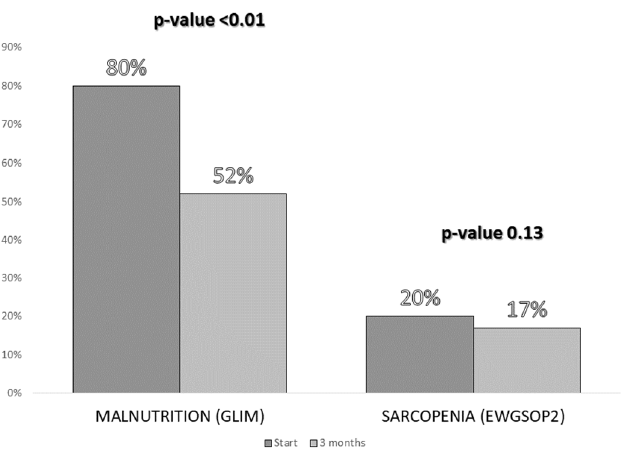
Figure 4. Comparison of the percentages of malnutrition (according to the Global Leadership Initiative on Malnutrition (GLIM) criteria) and sarcopenia (according to the European Working Group on Sarcopenia in Older People (EWGSOP2) criteria) before the intervention and 3 months after the start of the